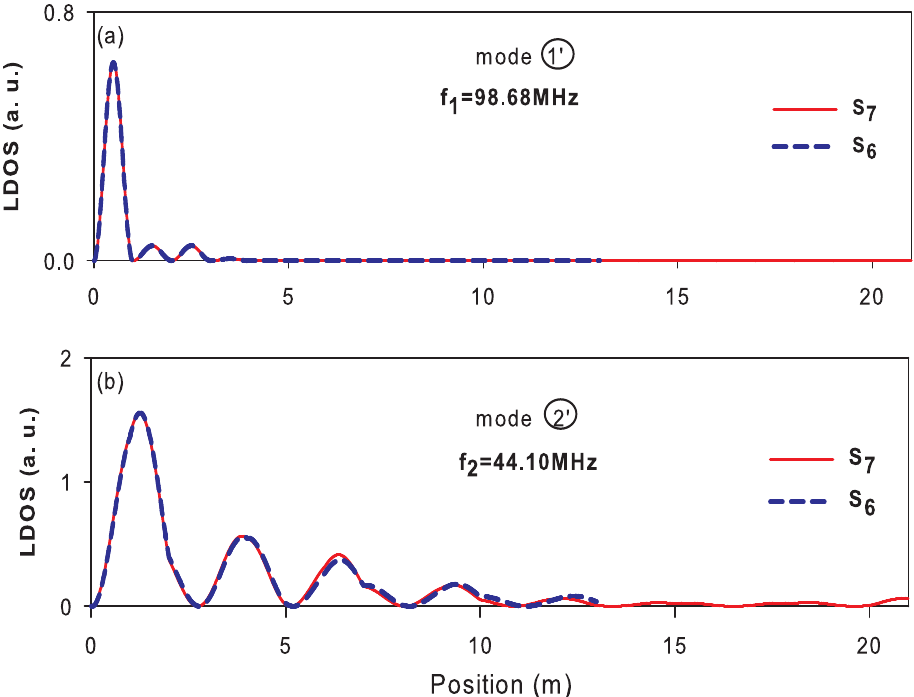
Figure 11. The LDOS (in arbitrary units) versus the space position x of the modes labeled 1 (cid:48) and 2 (cid:48) in Figure 10 at f 1 = 98.68 MHz ( a ) and f 2 = 44.10 MHz ( b ), respectively. Dashed (solid) curves correspond to the 6th (7th)